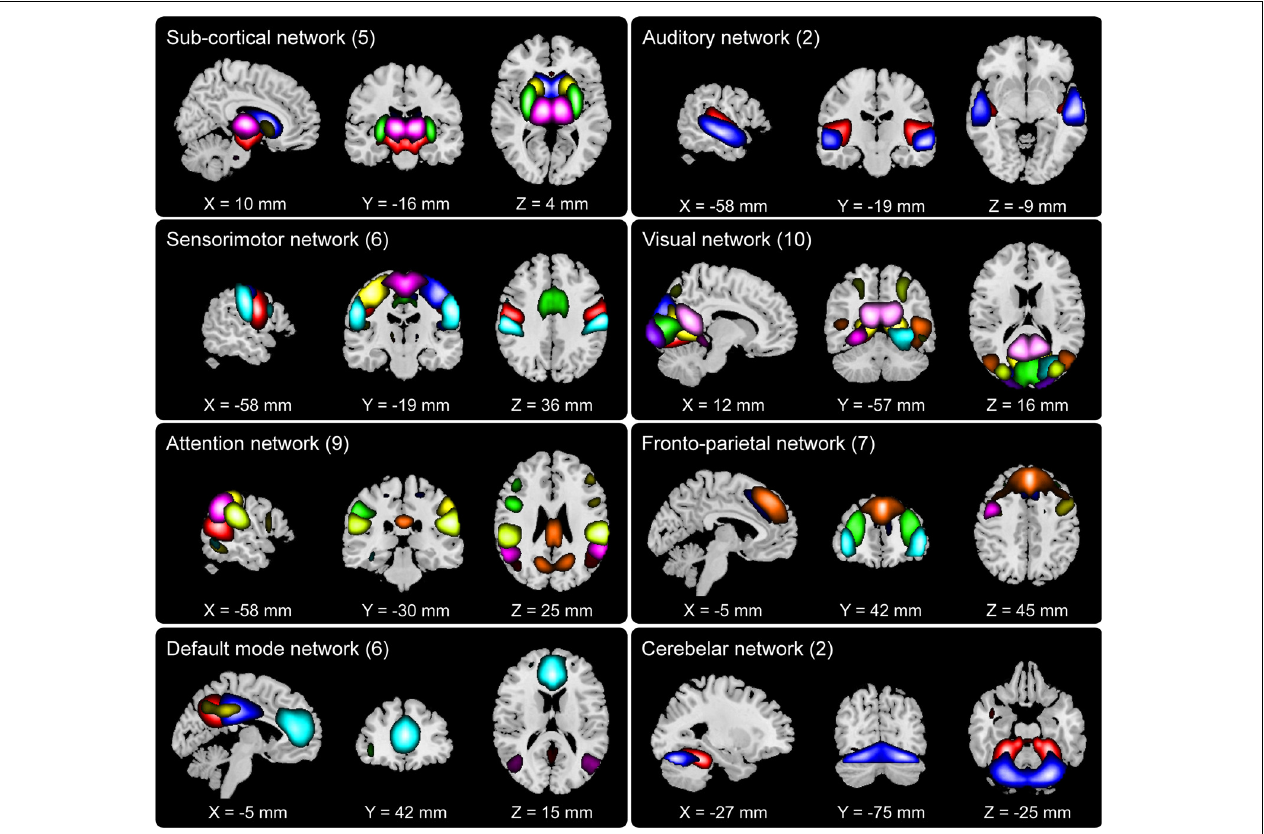
FIGURE 2 | Composite view of the 47 spatially independent group-level functional networks categorized into eight functional domains: subcortical (SC, 5 networks), auditory (AUD, 2), sensorimotor (SM, 6), visual (VIS, 10), attention (ATTN, 9), frontoparietal (FRN, 7), default mode (DMN, 6) and cerebellar (CB, 2). Intensity of the color represents z -scores. Functional network labels and peak activation coordinates can be found in prior work (Damaraju et al.,